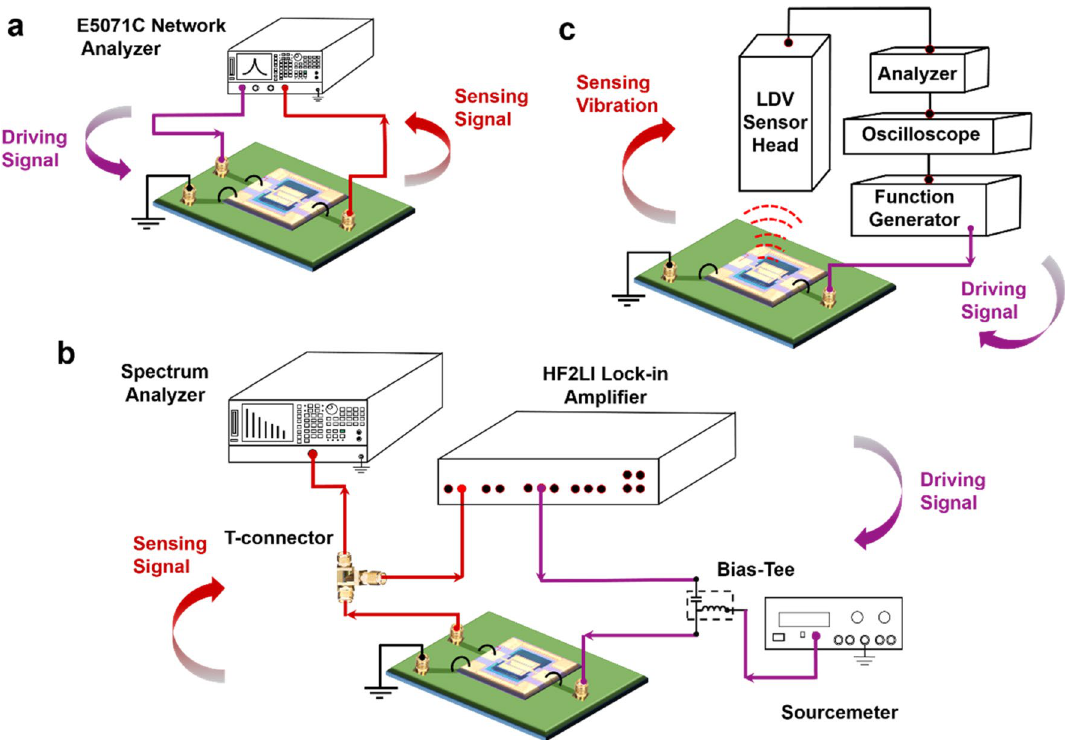
Figure 7. Measurement setup. Electrical-in Electrical-out arrangement: ( a ) Agilent Network Analyzer serves as the time-varying signal source. The driving power and the sweep frequency range can be precisely controlled using the Network Analyzer. ( b ) Zurich Instruments’ HF2LI Lock-in amplifier’s output is connected to the input of the resonator and the resonator’s output is connected back to the Lock-in amplifier and also to the SA using a T-connector. SA is used to record the harmonic generation for different drive conditions of the device. ( c ) Electrical-in Mechanical-out arrangement: An internal signal source of the LDV drives the resonator into resonance and the out-of-plane displacement of the resonator is recorded by the sensor head. Information in both the time and frequency domain can be attained. In addition to the magnitude and phase details, graphical files of the mode shape vibration are also